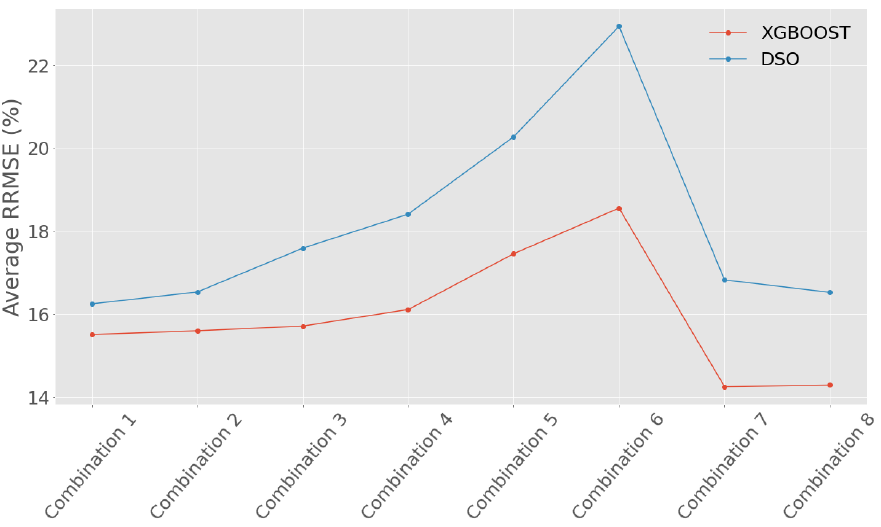
Figure 8. Average RRMSE for each